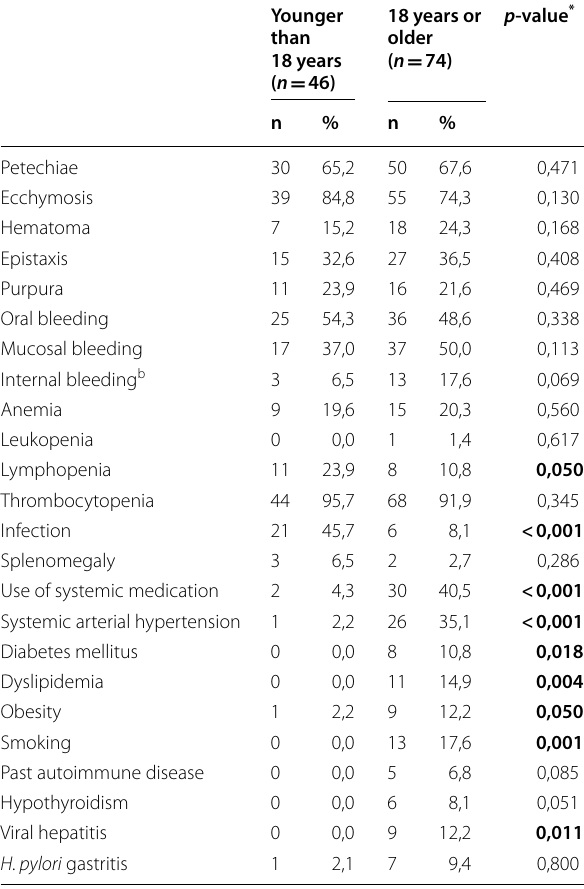
* Statistical tests used: Chi-square and Fisher exact. b Hemorrhages of the gastrointestinal tract, respiratory tract or central nervous system